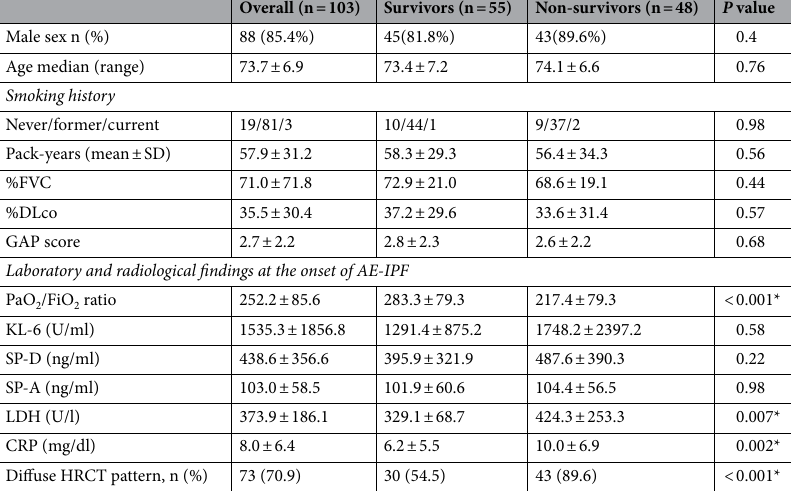
Table 4. The total score (PCR score) was calculated as [1 × PaO2/FiO2 ratio (< 250): (P)] + [1 × CRP (≥ 5.5 mg/ dl): (C)] + [1 × HRCT (radiological) findings (diffuse HRCT pattern): (R)]. The score ranged from 0 to 3. The